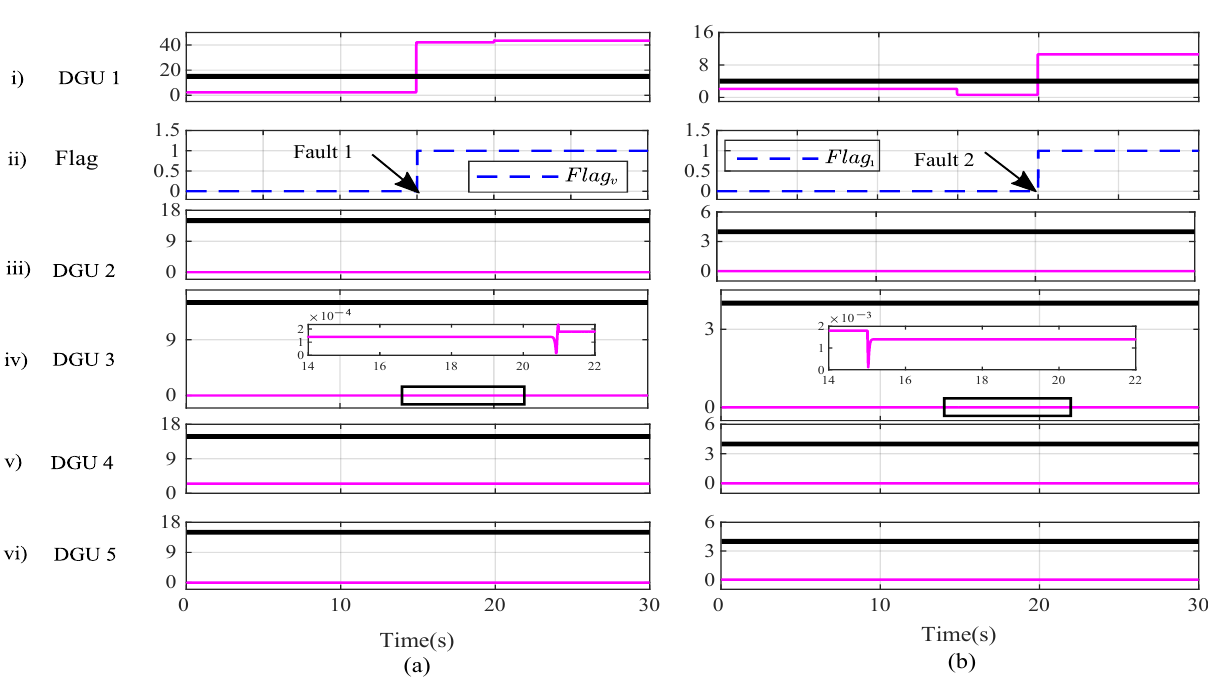
= − 0.9 and λ i = − 1. ( a ) Voltage i i